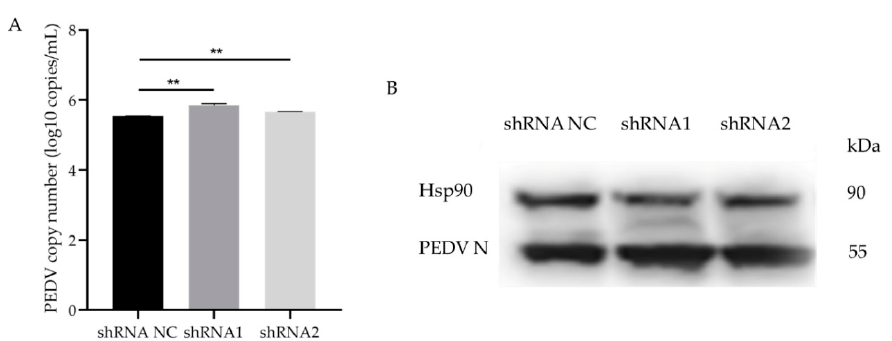
Figure 5. PEDV infects GLP-2 gene silent cell lines. ( A ) qPCR for determination of PEDV copy number in shRNA NC, in shRNA NC, shRNA1 and shRNA2 cells. ( B ) Western blot analysis of PEDV N protein. shRNA shRNA1 and shRNA2 cells. ( B ) Western blot analysis of PEDV N protein. shRNA NC represents negative control. shRNA1 NC represents negative control. shRNA1 shRNA2 and shRNA3 represent three RNA interference shRNA2 and shRNA3 represent three RNA interference fragments of GLP-2 gene. ** p < 0.01. Bars represent the mean ± fragments of GLP-2 gene. ** p < 0.01. Bars represent the mean ± SD ( n = SD ( n = 3).